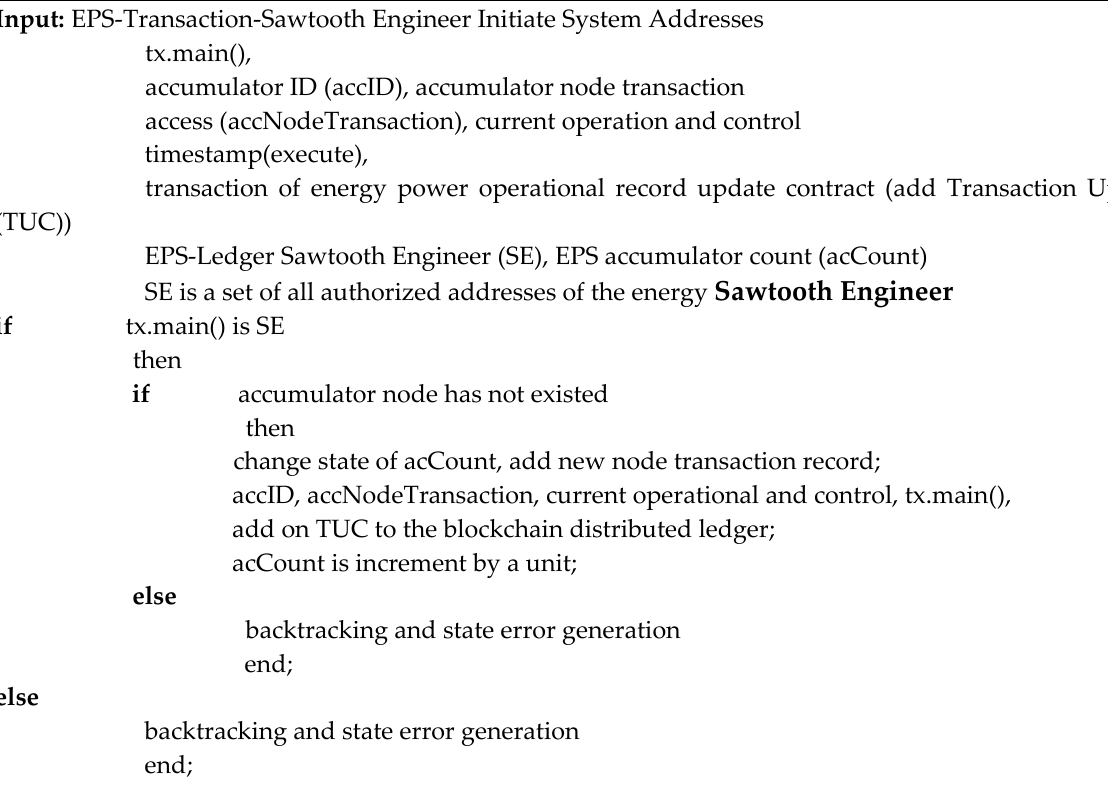
Algorithm 2 : addNode() Contract, The distributed power systems chain of operation and control accumulator Algorithm 3: updateTransaction() Contract, EPS-ledger transaction update contract (updateTransaction()). contract (addNode()).